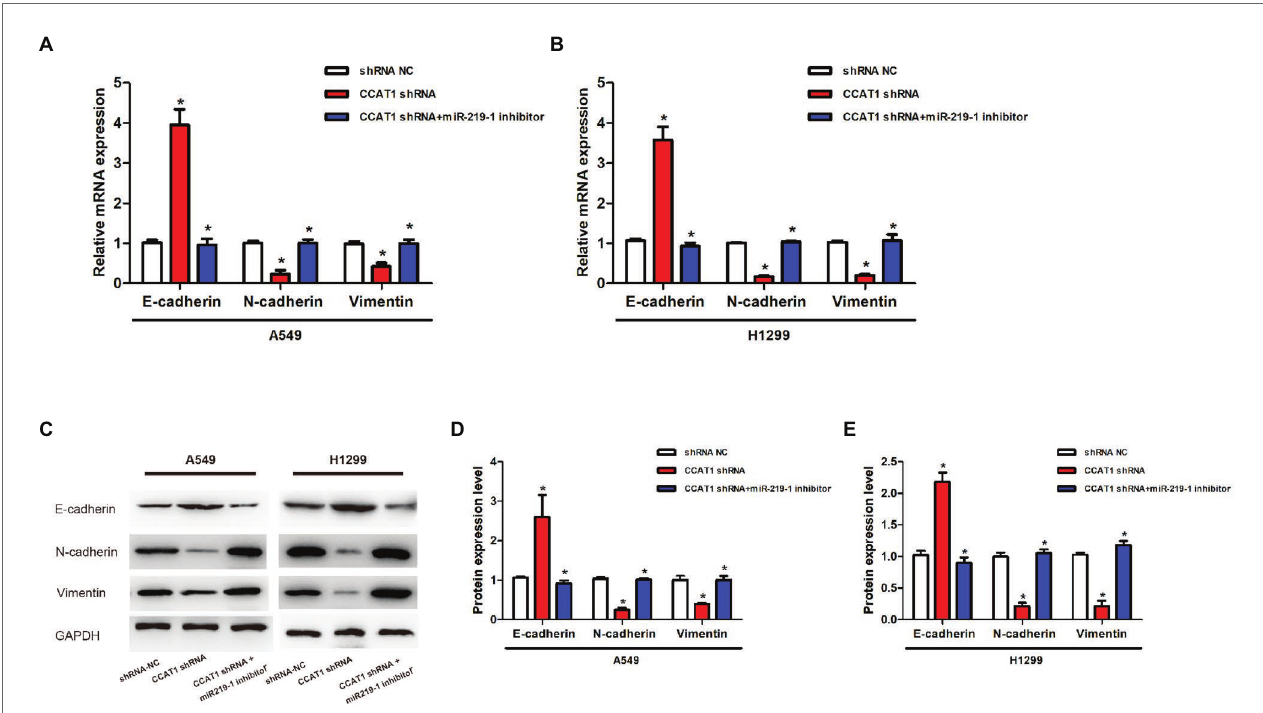
FIGURE 4 | Effects of CCAT1 and miR-219-1 on the expression of protein in LAD cells. (A,B) The relative expressions of mRNA of E-cadherin, N-cadherin, and vimentin in A549 and H1299 cells transfected with shRNA NC, CCAT1 shRNA, and CCAT1 shRNA+ by the miR-219-1 inhibitor. (C–E) Expression of E-cadherin, N-cadherin, and vimentin determined by western blot. * p <